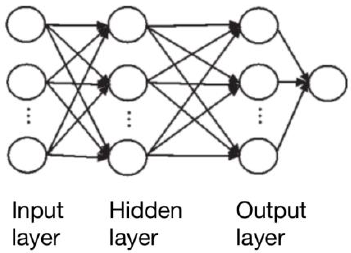
Figure 5. Bayesian Network Model.